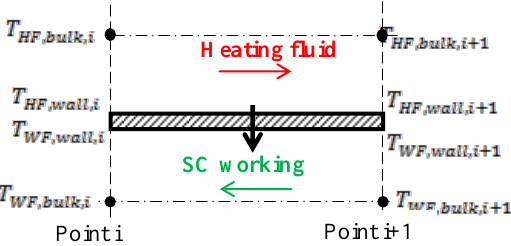
Figure 4. Control volume depicting the inlet/outlet temperatures of the two fluids.